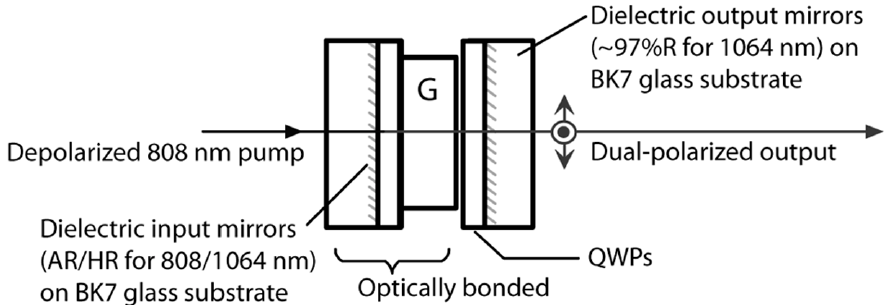
Figure 1. Schematic diagram of dual-frequency ceramic microchip Nd:YAG laser [20] . QWP: quar- ter-wave plate; G: glass.